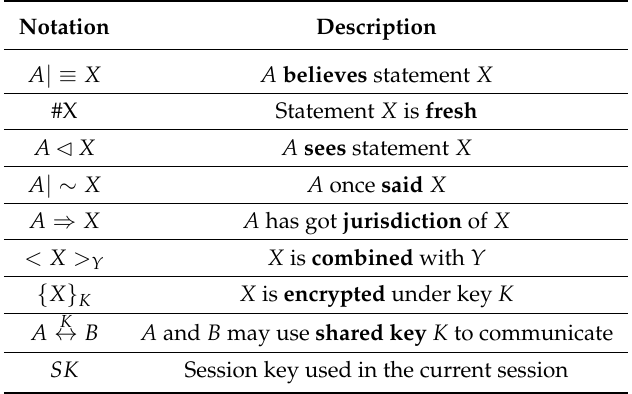
Table 2. Notations for BAN